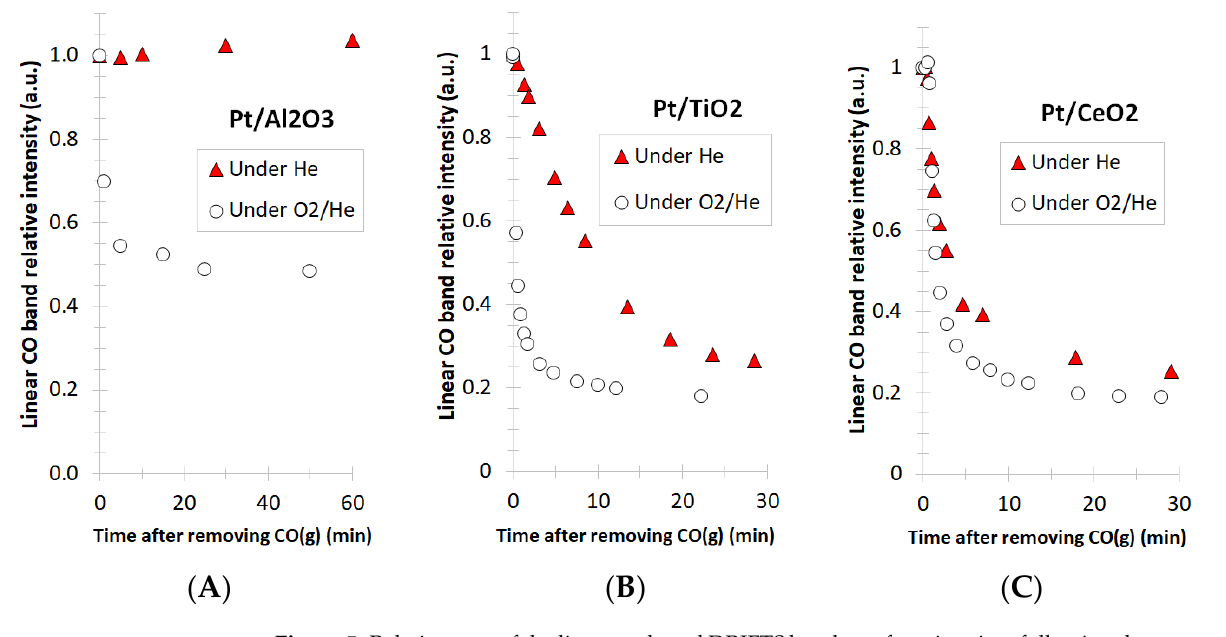
Figure 5. Relative area of the linear carbonyl DRIFTS band as a function time following the removal of CO from the feed measured over Pt supported on ( A ) alumina, ( B ) titania and ( C ) ceria. The